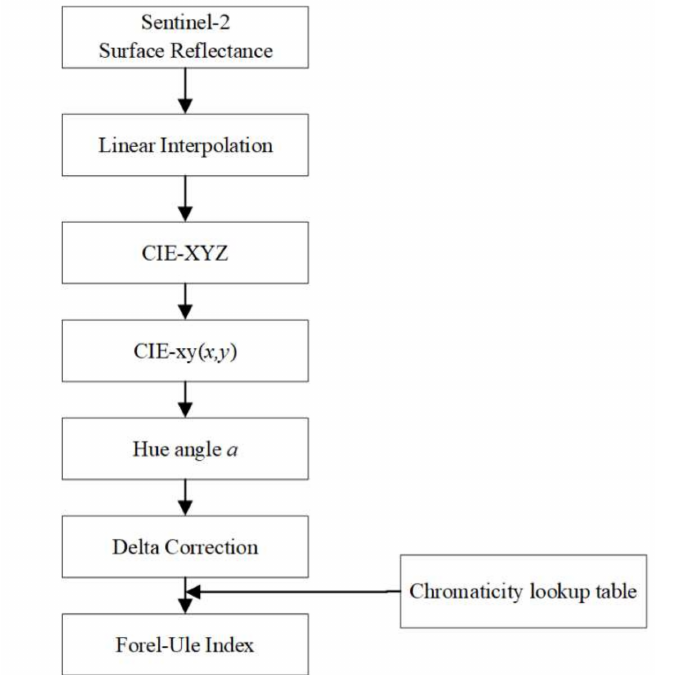
Figure 4. Flow chart of Forel-Ule Index [Adapted with permission from ref. [33]. Copyright 2020 Shenglei Wang